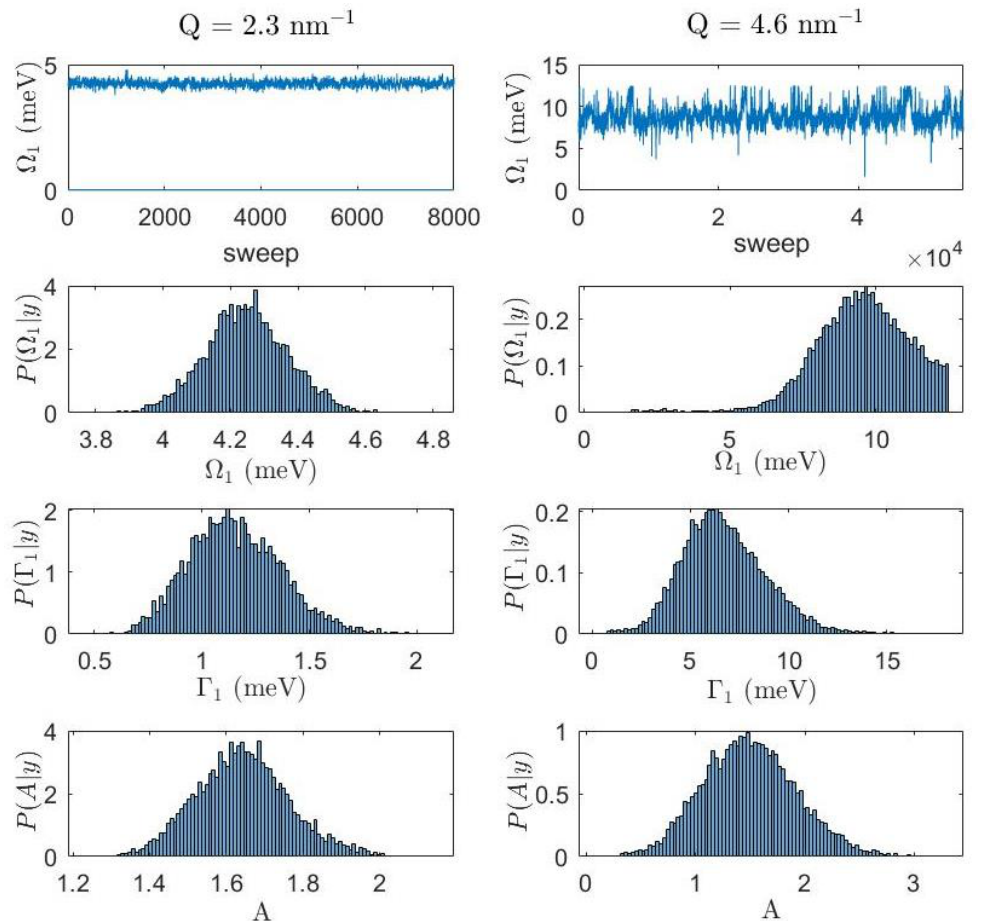
Figure 6. The trace plot of Ω 1 (upper two panels) and the posterior distribution of the various DHO 1 parameters for the Au–NP suspension, are reported for the two indicated Q values; the posterior distributions reported in the ordinate axis are nothing but the conditional probability of a given model parameter having observed the collected experimental data y